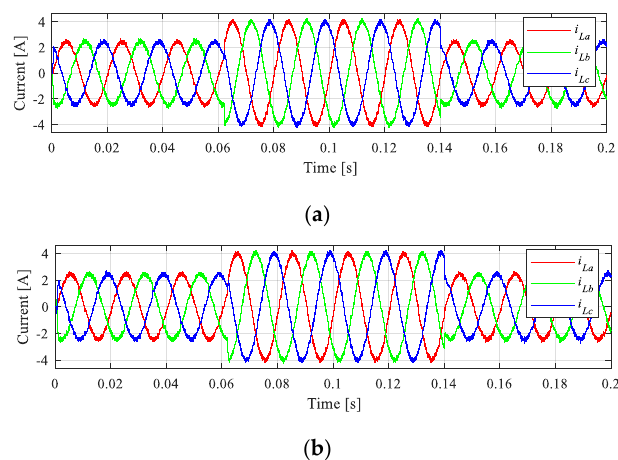
Figure 6. Simulation result: three-phase load current for the FS-MPC in ( a ) αβ -frame and ( b ) dq -frame.